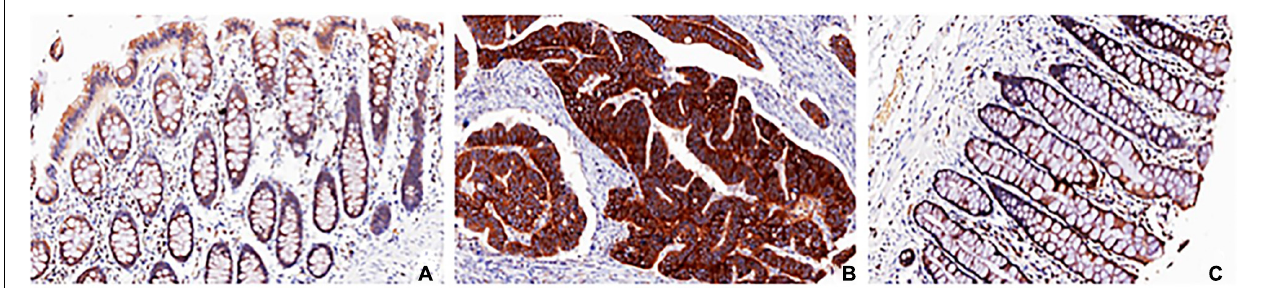
FIGURE 3 | Histochemistry of SLC7A1 in colorectal cancer and control. The pathological characteristics of colon adenocarcinoma (B) and adjacent normal colon tissue (C) in the tumor specimen were shown when sectioning and staining with anti-SLC7A1 antibody and compared with normal colon tissue from control (A)